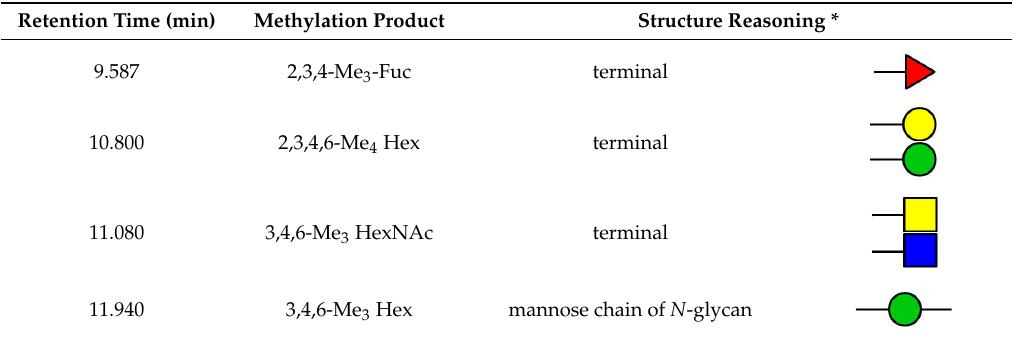
Table 1. Results of the methylation analysis.